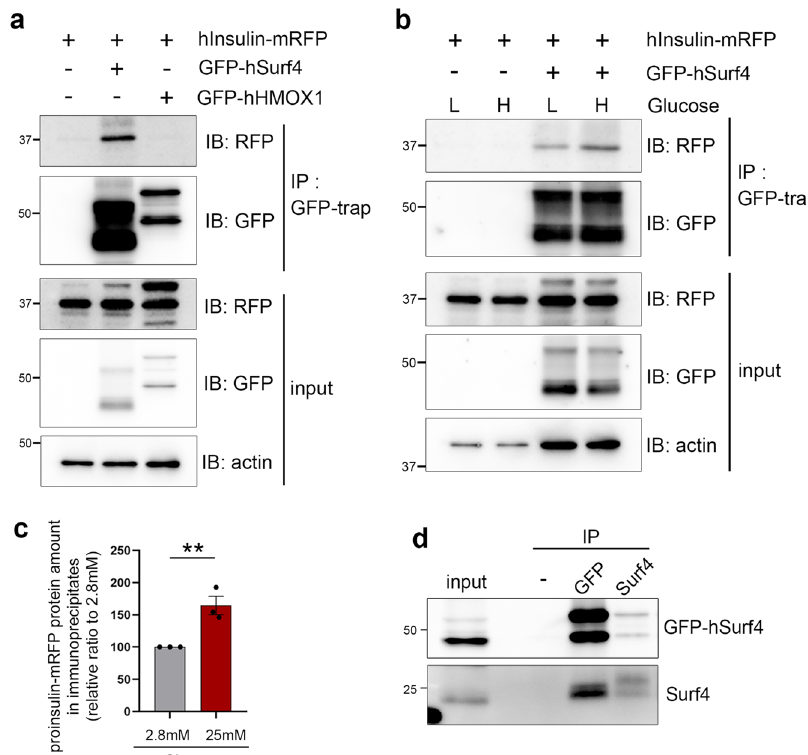
Fig. 5 Surf4 physically interacts with proinsulin. a INS-1 832/13 cells expressing human Insulin (hInsulin)-mRFP and GFP-human Surf4 (hSurf4) or GFP- human HMOXl (hHMOX1) were immunoprecipitated with a GFP-trap. Immunoprecipitates (IP) and 0.2% of the total lysate (input) were immunoblotted with anti-RFP, anti-GFP, and anti- β -actin antibodies. An approximately 37 kDa protein, which was predicted to be a proinsulin-mRFP, was co- immunoprecipitated with GFP-hSurf4 but not with GFP-hHMOX1. b INS-1 832/13 cells expressing hInsulin-mRFP and GFP-hSurf4 were incubated in KRB containing low- (L: 2.8 mM) or high- (H: 25 mM) glucose for 15 min. Cells were then immunoprecipitated with the GFP-trap. Immunoprecipitates (IP) and 0.2% of the total lysate (input) were immunoblotted with anti-RFP, anti-GFP, and anti- β -actin antibodies. c Quanti fi cation of hInsulin-mRFP protein amount contained in immunoprecipitates following low- or high-glucose stimulation ( b ; n = 3). Data are presented as the mean ± standard error of the mean and analyzed by two-tailed t -test, ** p < 0.05. d INS-1 832/13 cells expressing GFP-hSurf4 were immunoprecipitated with anti-GFP and anti-Surf4 antibodies. IP and 1% of the total lysate (input) were immunoblotted with anti-Surf4 and anti-GFP